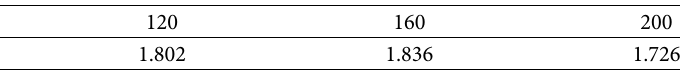
Table 6: The PCF with different height of rock plate.